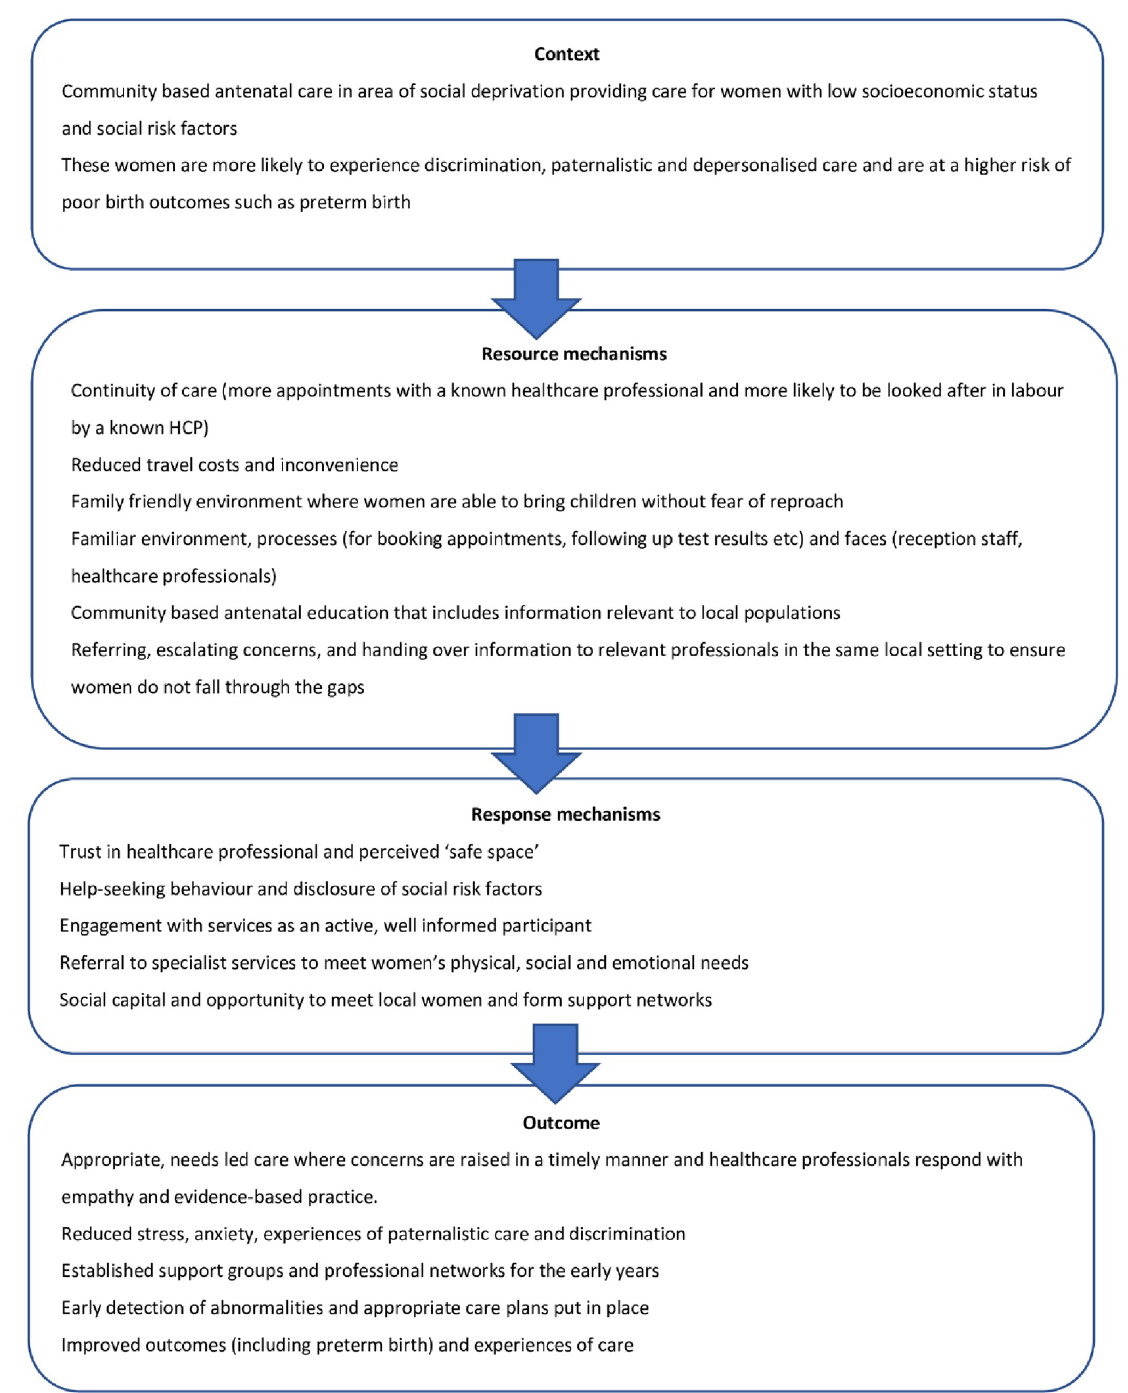
Fig 2. CMO configuration to reduce inequalities seen in preterm birth